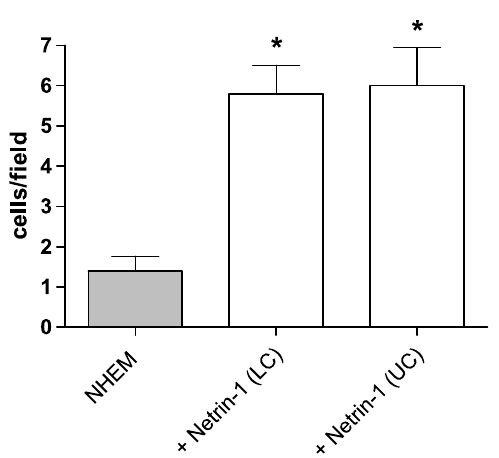
Fig. 3. Influence of Netrin-1 on migration of melanocytes. Hu- man normal epidermal melanocytes were treated with Netrin-1 and migration was assessed in the Boyden Chamber model. Netrin (100 ng/ml) was either given into the lower (LC) or the upper cam- ber (UC). All experiments were performed in duplicate and repeated three times with consistent results. Bars display mean + SD, sta- tistical analysis was performed using a Student’s unpaired t -test. (* p < 0 .